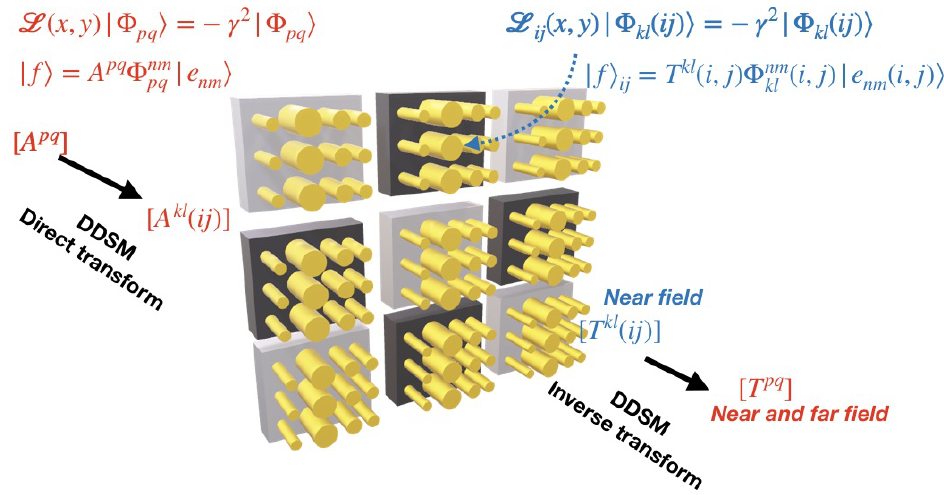
Figure 2. Sketch of the direct and inverse transform of DDSM applied to the near and far fields simulation of a photonics